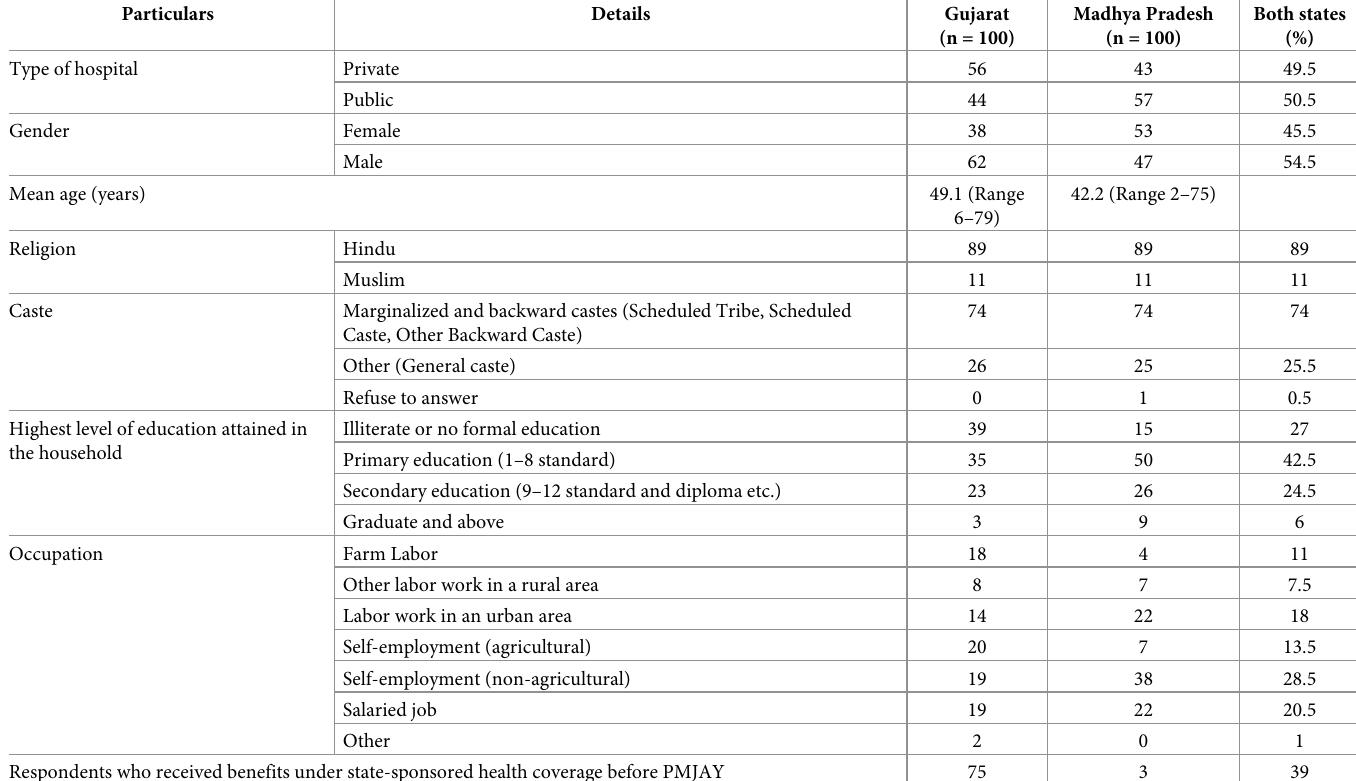
Table 2. Profile of the surveyed